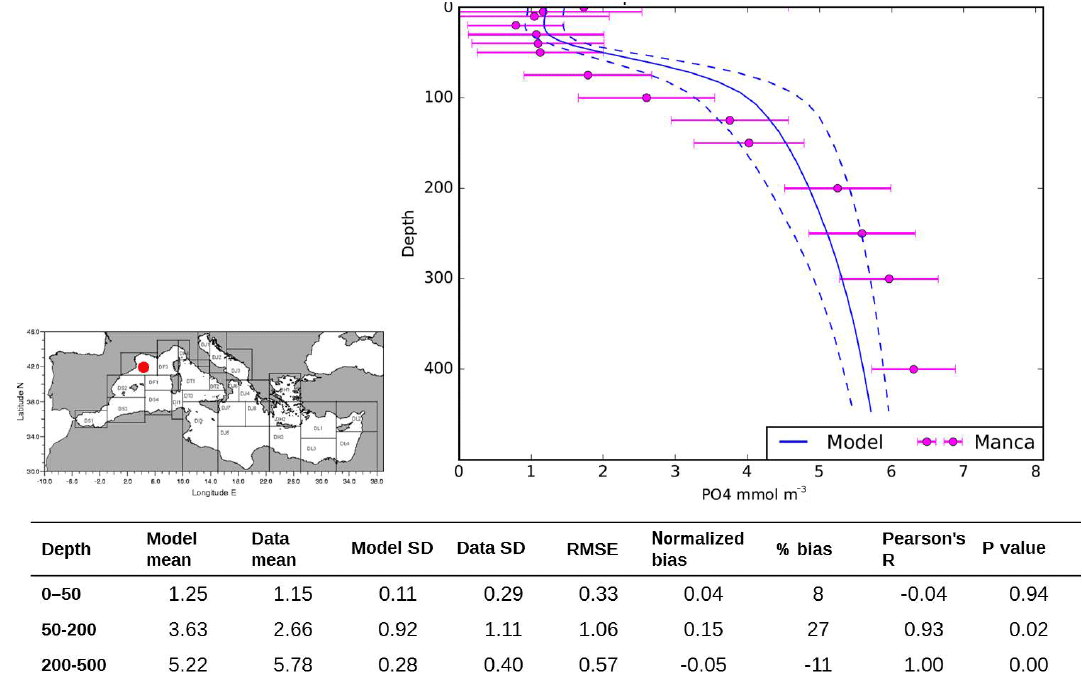
Figure A10. Annually averaged NO 3 vertical profile in the Gulf of Lion sub-basin (see map and Manca et al., 2004) and statistical indicators over different depth. Model values are shown with the blue line (2005 average, Ntot simulation from Richon et al., 2017) and measured values from Manca et al. (2004) are in pink. Horizontal bars and dashed lines indicate the spatial SD of observations and model results